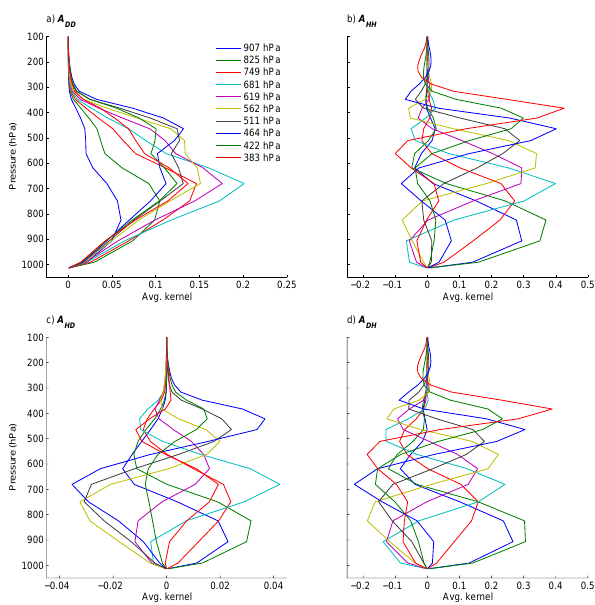
Fig. 2. Averaging kernels for the retrieval at 10:00UTC, 9 Decem- ber 2006 at (3.0 ◦ N, 53.75 ◦